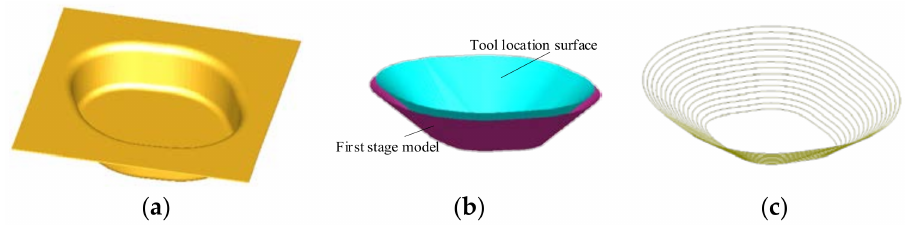
Figure 7. First stage forming toolpath: ( a ) the straight wall part model; ( b ) the first stage forming model and the tool location surface; and ( c ) the first stage forming toolpath.